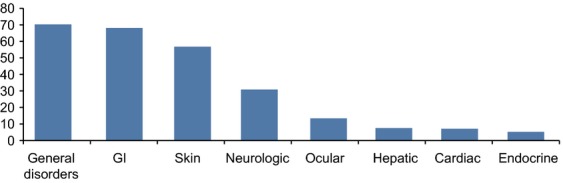
Percentage of any grade adverse events (AEs) 30. In a retrospective review of 1498 patients using safety data from 14 completed clinical trials, AEs were categorized by organ system. AEs were included regardless of causality. Patients may have experienced more than one event.